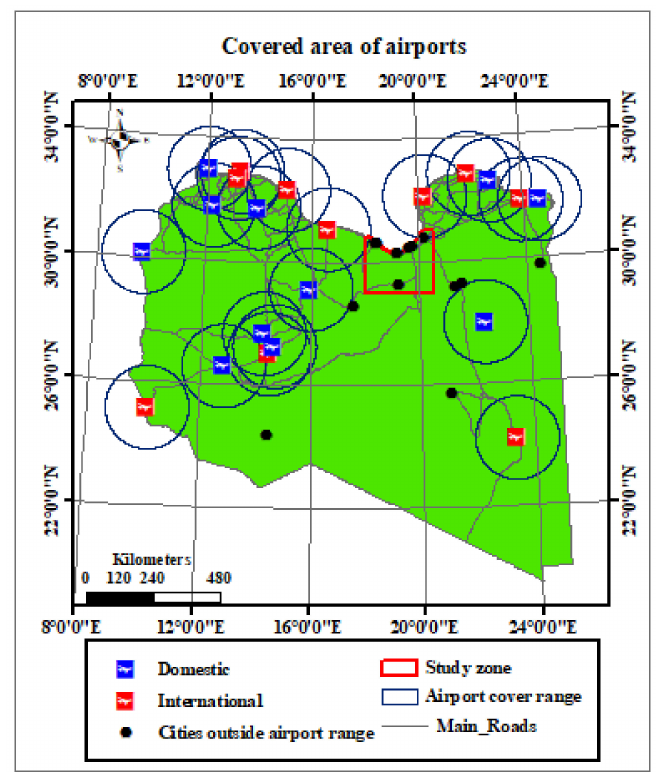
Figure 3. Result of spatial analysis.